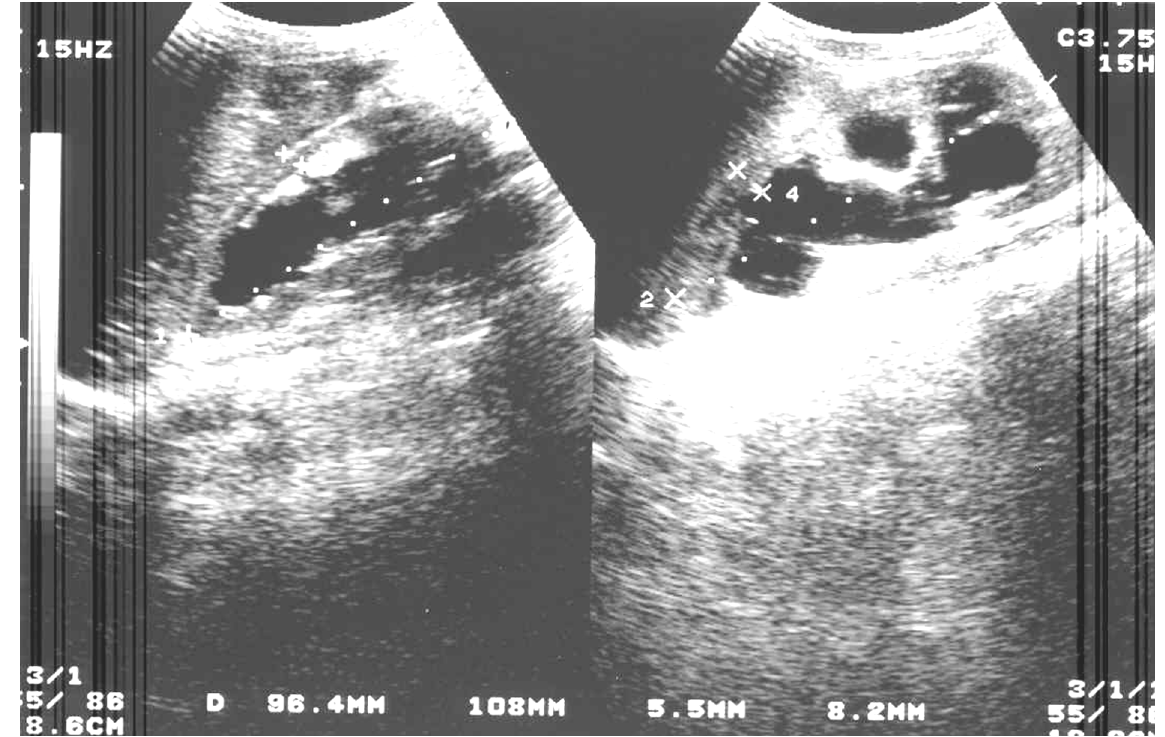
Figure 4 – Ultrasound of the hydroureteronephrosis and thinned parenchyma of the 11 year old